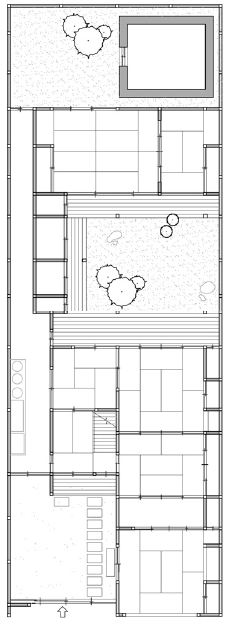
Figure 4. Plan of a machiya (Drawn by Hamed Aali).